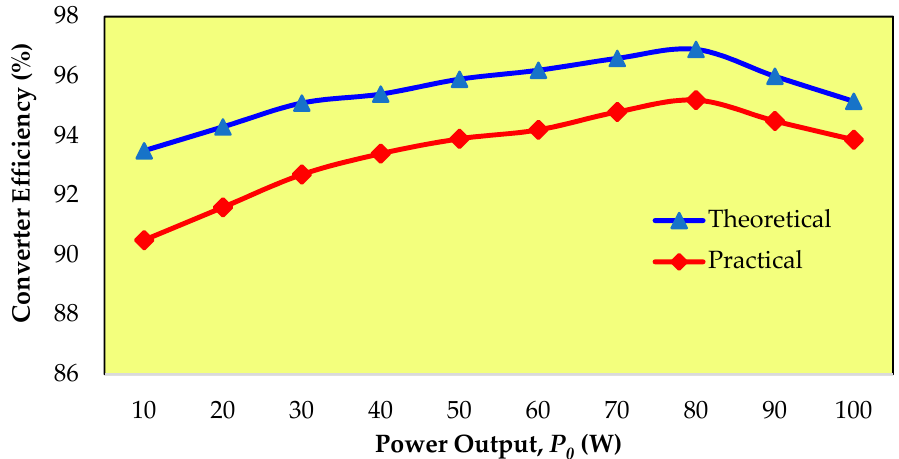
Figure 15. Performance evaluation of the proposed converter. Figure 16. Performance evaluation of the proposed converter.